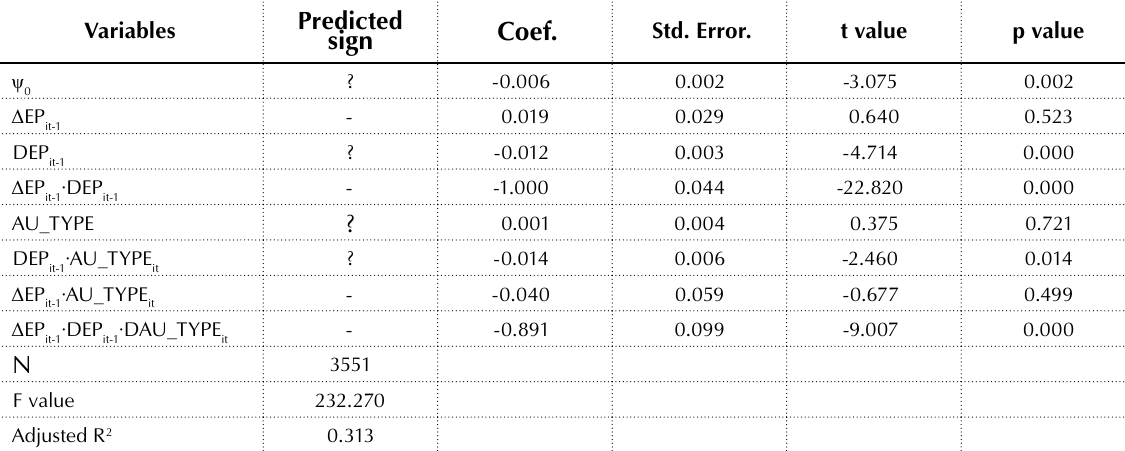
Table 6. Persistence of price-deflated earnings changes and organization type Predicted Variables sign